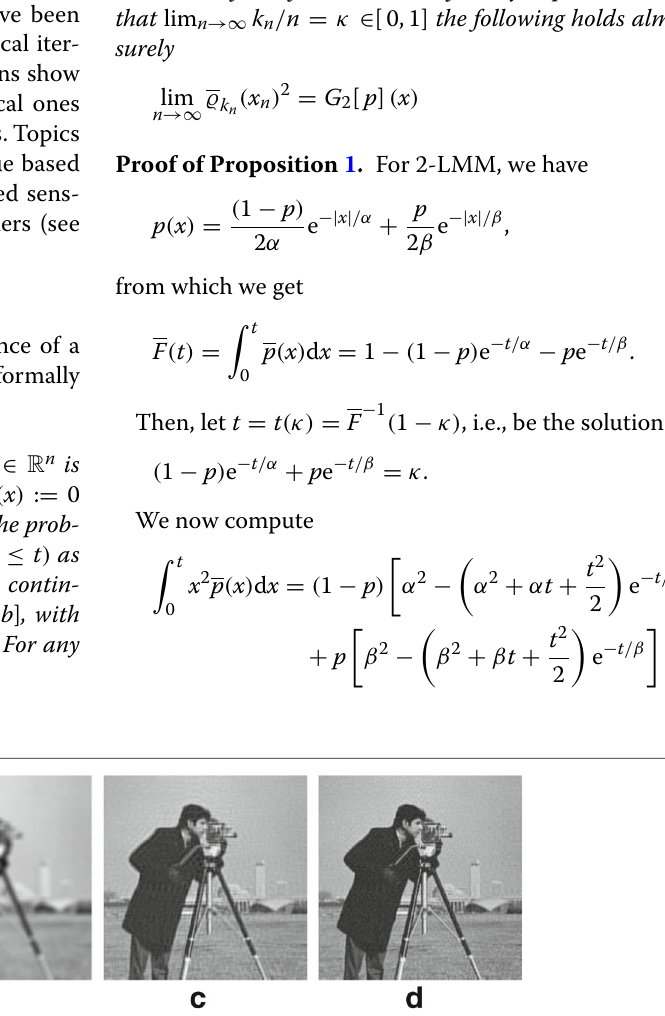
Fig. 14 Analysis of performance for cameraman image deblurring: a original image, b acquired image, c FISTA reconstruction MSE (dB) = − 11.4731 (after 1000 iterations), d 2-LMM-FISTA reconstruction MSE (dB) = − 14.4731 (after 1000